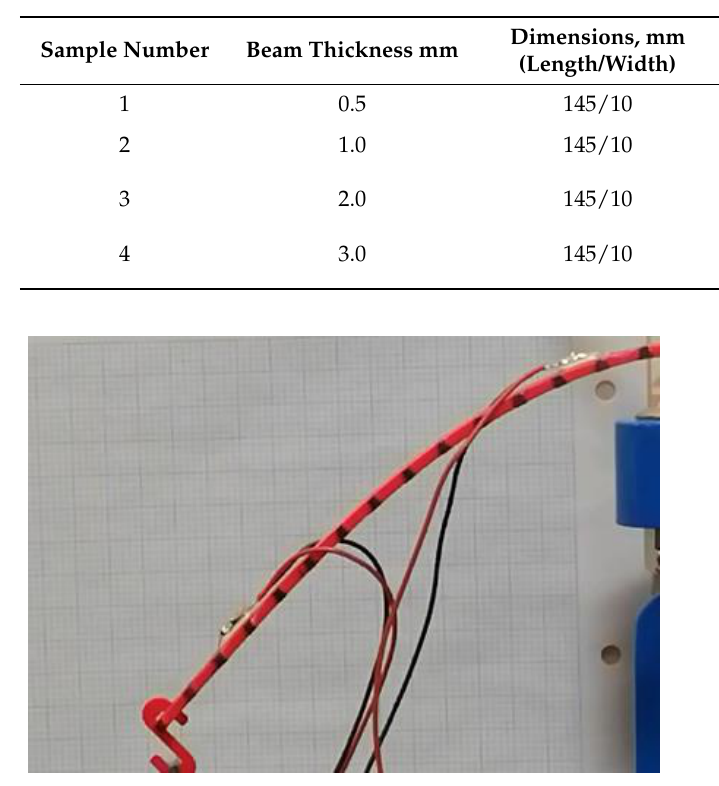
Figure 6. Deflection points. Table 3. Origami capsule designs.